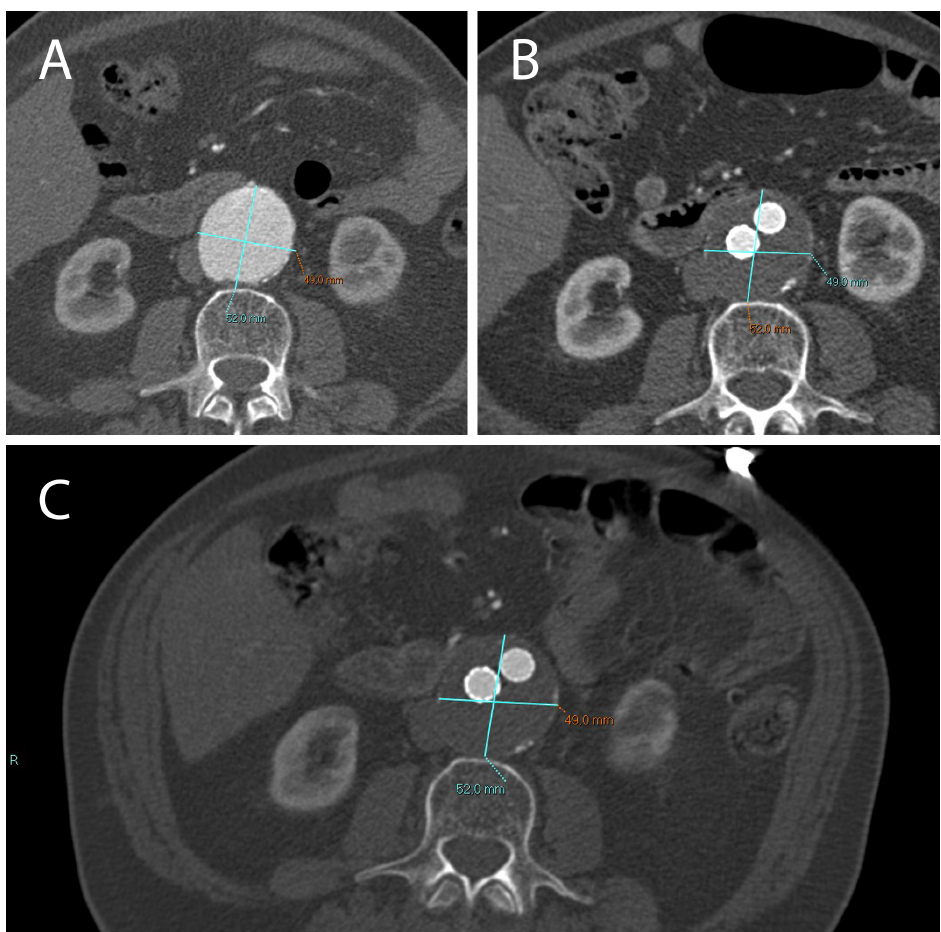
Figure 2. Dots represent size (cm) of aneurysms in patients developing endoleaks ( n = 6) ( A ), and in patients who did not develop endoleaks ( n = 12) ( B ). Patients were analyzed at baseline (T0) and after 1, 6, and 12 months following EVAR intervention, as established in the clinical protocol.